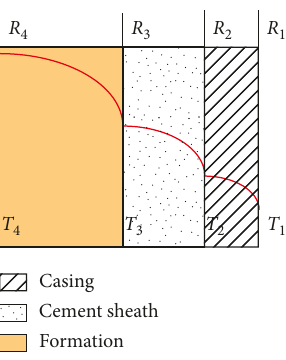
Figure 12: The distribution of interface